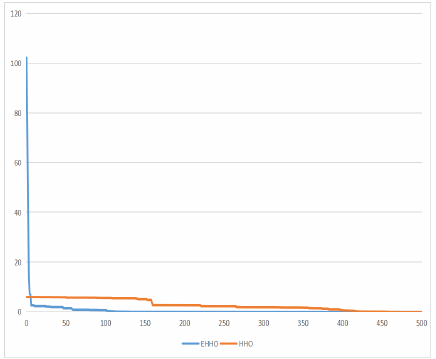
Figure 7. Booth function.